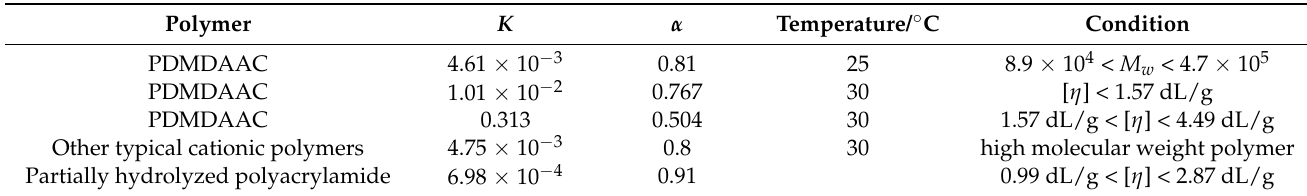
Table 2. The values of K and α in the Mark-Houwink equation